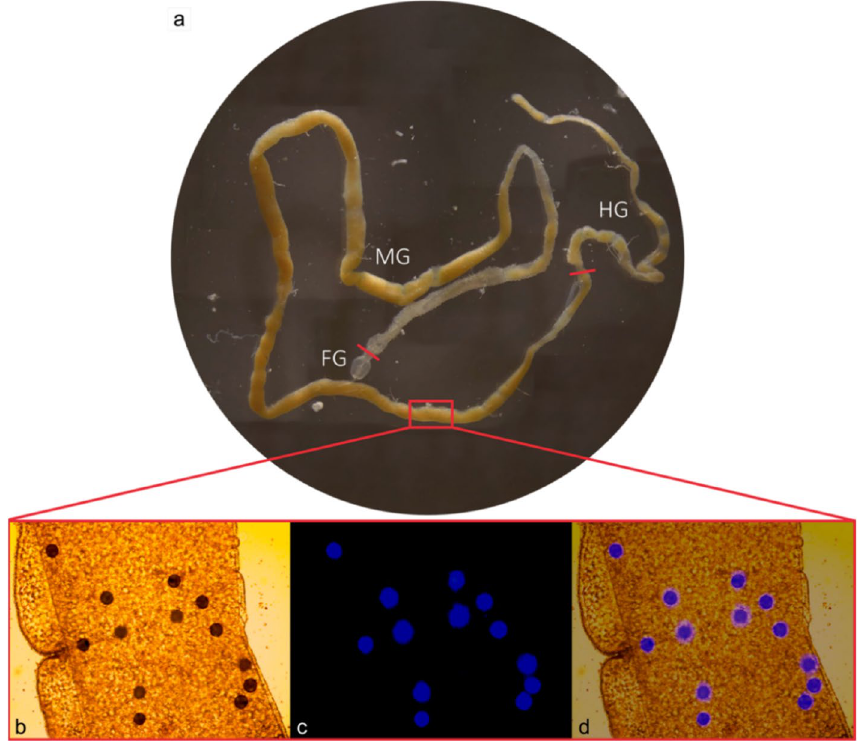
Figure 2. ( a ) Image of the complete gut and its different sections of a BSF larva as shown under a stereo microscope (magnification: 8 x). ( b ), ( c ), and ( d ) show different images of the same larval gut section (magnification: 10 x). ( b ) Light microscope image, ( c ) fluorescence microscope image, and ( d ) an overlay of both images, to visualise the microplastics present in the lumen of the larval gut. FG, MG, and HG represent the foregut, midgut, and hindgut,